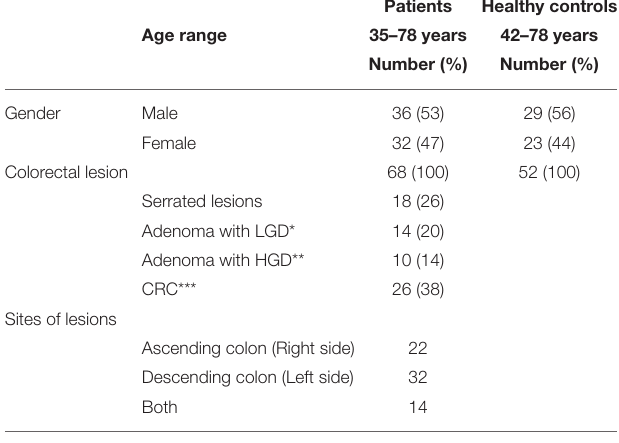
TABLE 1 | Patients and HC characteristics.